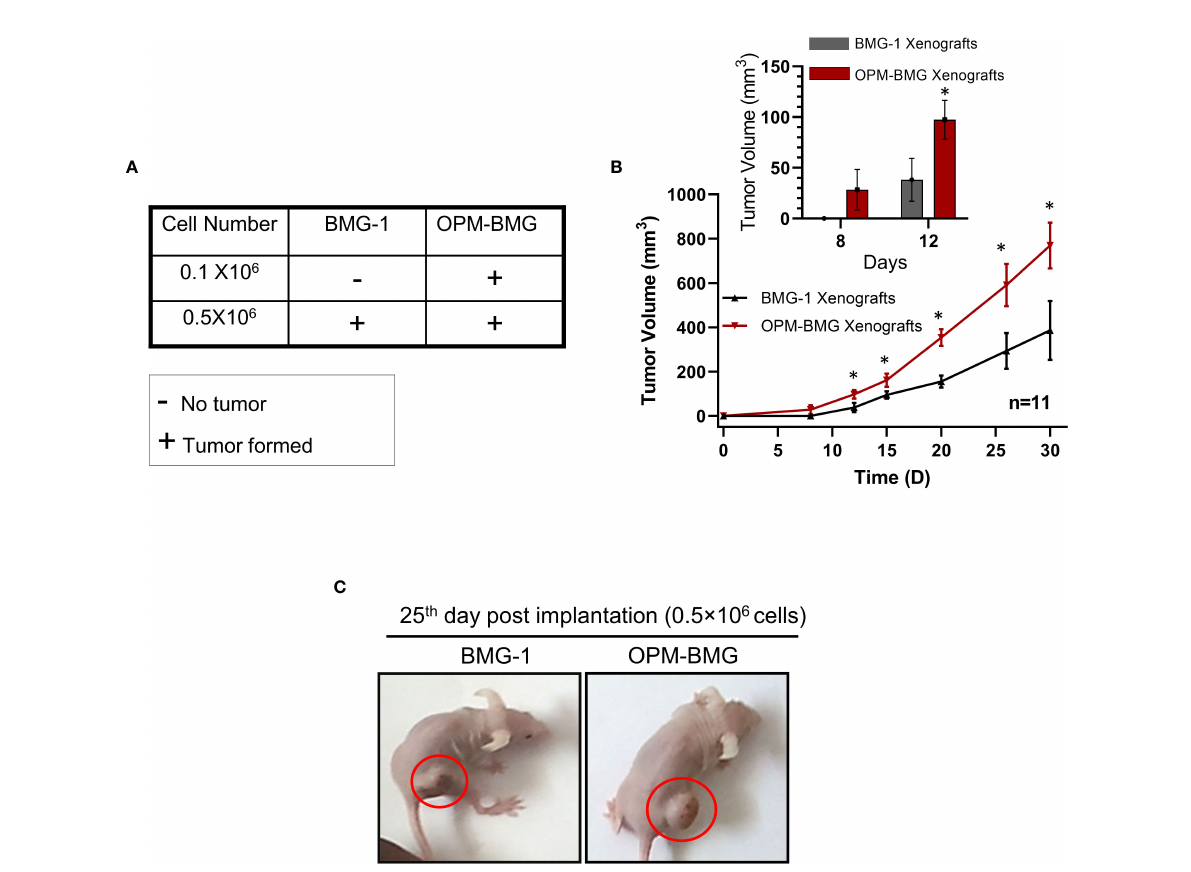
FIGURE 4 OPM-BMG xenografts showed an increased tumorigenic potential and rapid growth rate. (A) . Tumor take analysis was carried out with indicated cell numbers in BMG-1 and OPM-BMG cells (n=5/group). (B) . The tumor volume of BMG-1 and OPM-BMG grafted tumors (n=11 mice/group) were plotted, showing an exponential increase in tumor volume (y-axis mm 3 ) with the indicated number of days (x-axis) obtained from two independent observations. An inset bar plot compares the fi rst tumor volumes measured in BMG-1 and OPM-BMG xenografts following the development of the initial palpable tumor nodules. (C) . Athymic, nude mice images are presented from BMG-1 and OPM-BMG groups, depicting the difference in tumor size captured at the 25 th -day post-implantation. Data are presented as the mean ± SD; an unpaired two-tailed Student ’ s t-test was performed to calculate the statistical signi fi cance between BMG-1 and OPM-BMG tumor xenografts and presented as * P ≤ 0.05 with respect to BMG-1